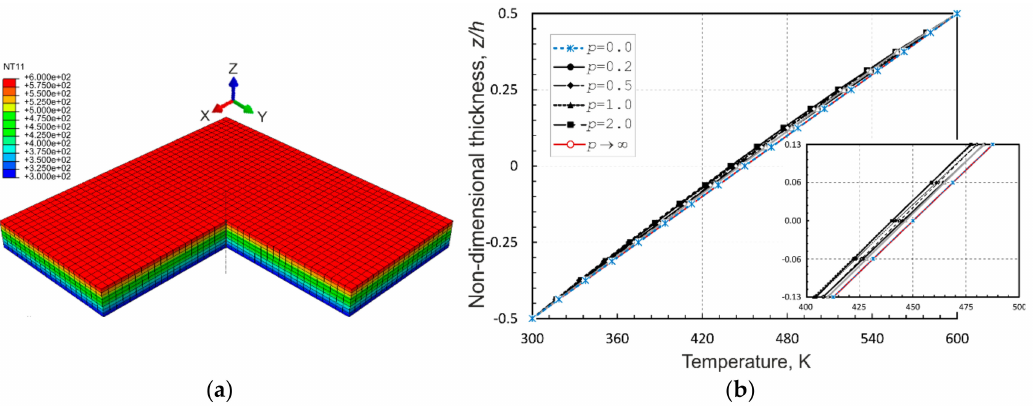
Figure 5. For simply supported and clamped plates: ( a ) temperature distribution and ( b ) through-the- thickness profiles of the temperature.